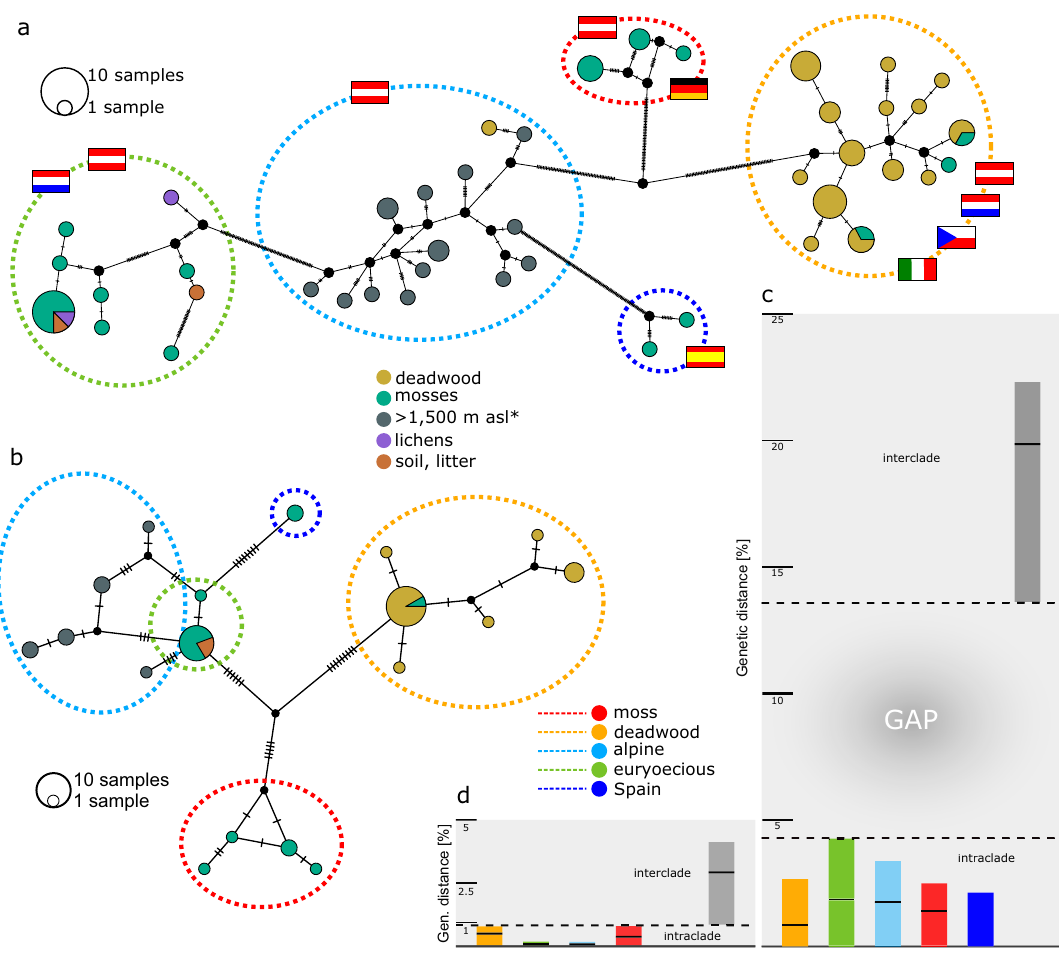
Figure 2. Haplotype networks and genetic distances for mitochondrial ( a , c ) and nuclear ( b , d ) genes. TCS Network of ( a ) mtDNA dataset (N = 70) and ( b ) nuDNA dataset (N = 45). Colors of circles show ecological traits and colored, dashed borders correspond to species clades detected in Fig. 1. Flags show country of origin specimens of clades were sampled in (Austria, Germany, Italy, Czech Republic, Spain, and Croatia). Each circle corresponds to one haplotype and its size is proportional to its frequency, the number of mutations between haplotypes are indicated as hatch marks. Small black circles represent intermediate haplotypes not present in the dataset. Minimum, maximum, and mean intercladal (gray) and intracladal (colors refer to clades defined in Fig. 1), uncorrected genetic distance ( p -distance) in percent given for the ( c ) mtDNA dataset and ( d ) nuDNA dataset. Further information on mean uncorrected distances are given in Supplementary Information online (Table S3). *found in various